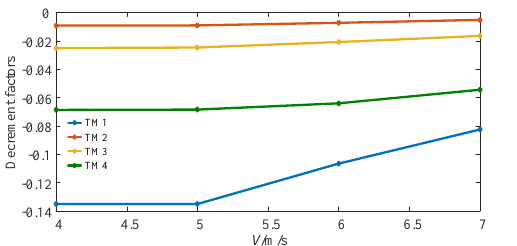
Figure 10. Damping coefficient for each torsional mode of SG under different operating conditions.